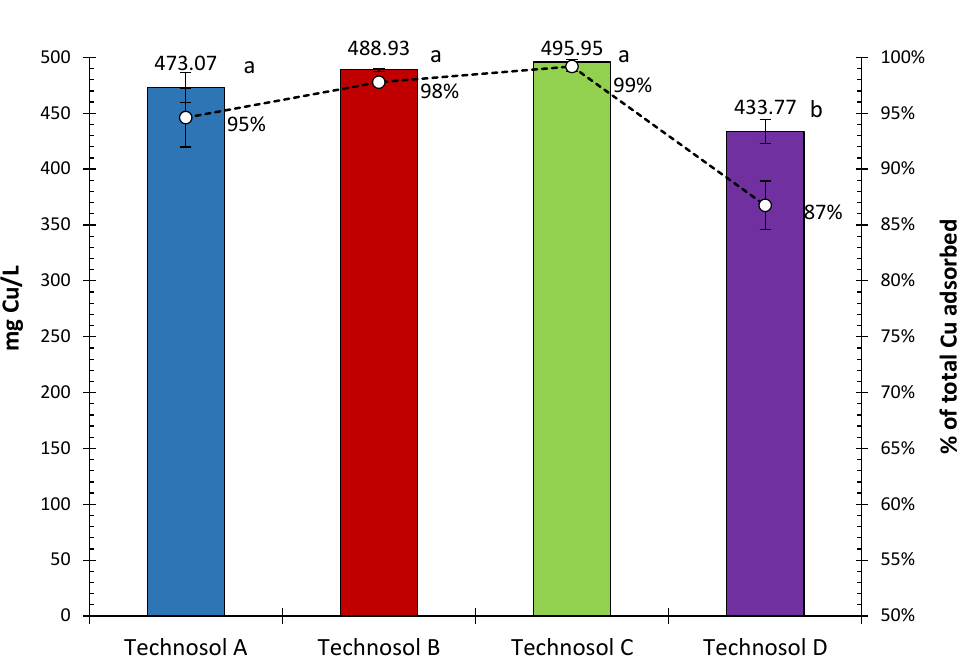
Figure 1. Mean concentration (bars) and percentage (dashed line) of total copper adsorbed by Technosols in the batch experiment. Values indicated by same letters in columns do not differ according to the Tukey test ( p < 0.05) between Technosols ( n = 3).